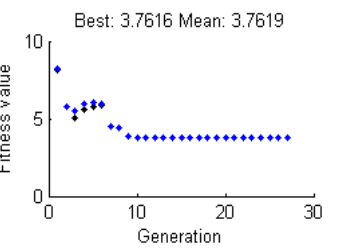
Fig.9. Convergent of one-dimension projection